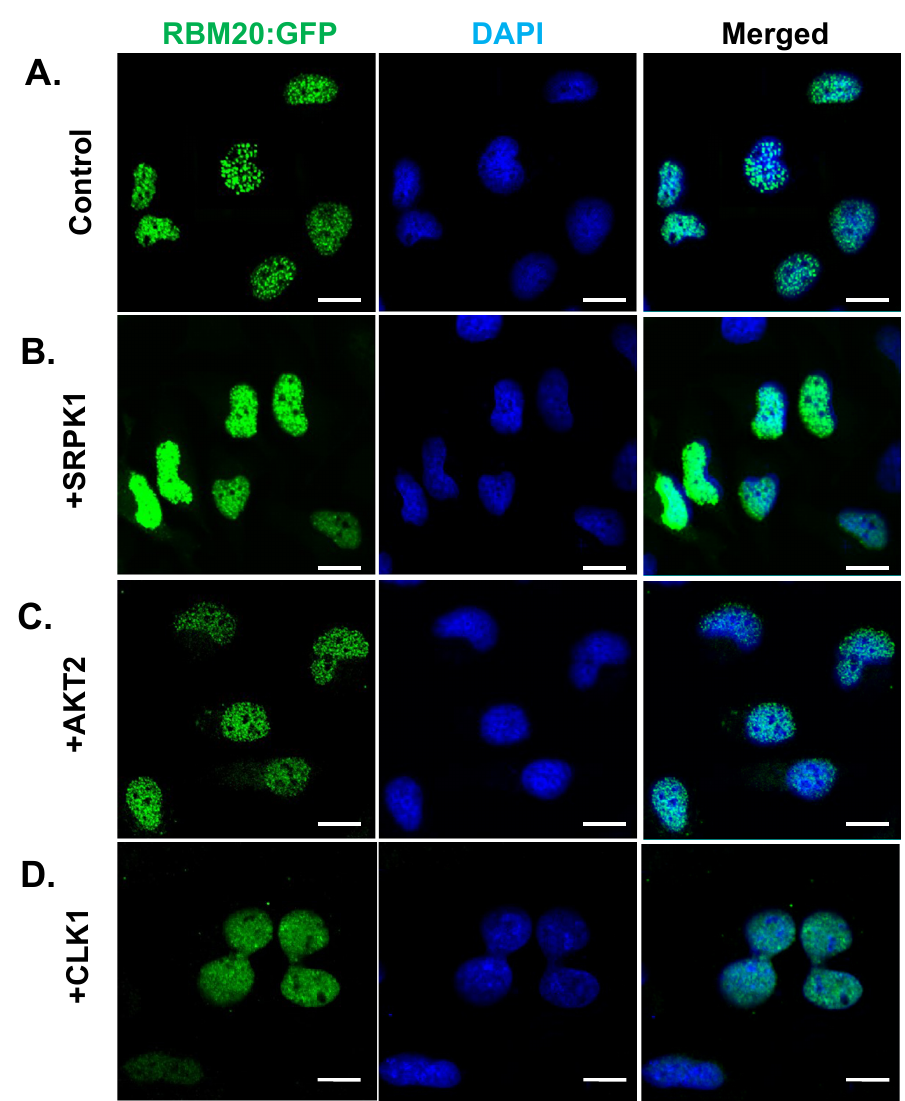
Figure 6. RBM20 localization in HeLa cells overexpressing CLK1, SRPK1, and AKT2. ( A ) Immuno- cytochemical staining of RBM20 in cells co-transfected with empty plasmid (no kinases control). ( B – D ) Immunocytochemical staining of RBM20 in cells co-transfected with SRPK1 ( B ), AKT2 ( C ), or CLK1 ( D ). Scale bars are 20 μ m.